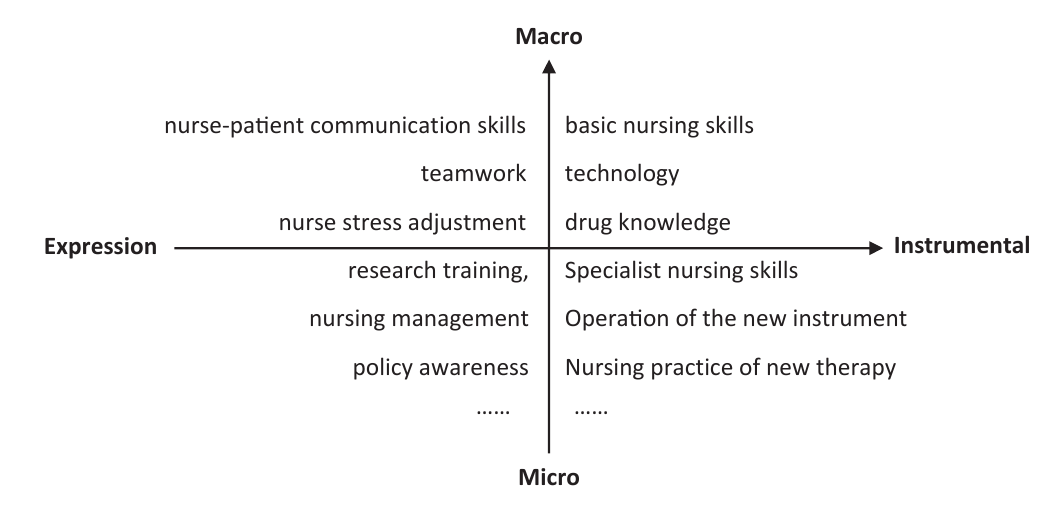
Figure 1. The framework of TNA. TNA, training need analysis.